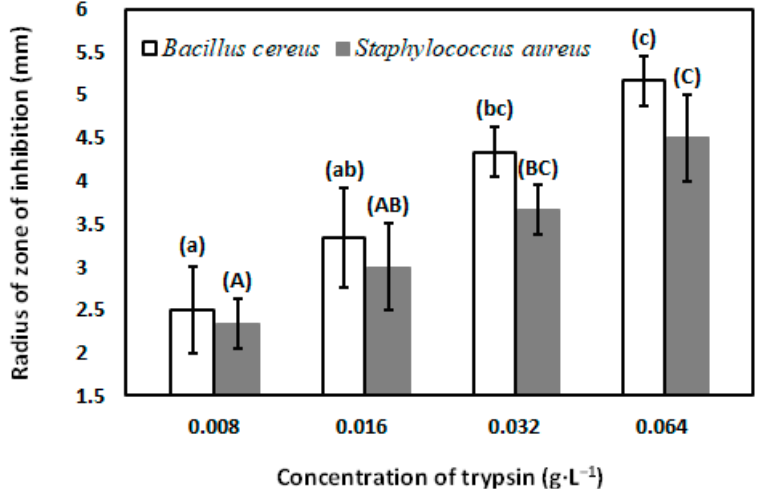
Figure 9. Antibacterial activity of milk with concentrated proteins after enzyme treatment. Results are represented by mean value with standard deviation (± values). Superscript dissimilar alphabet represents the significant difference between results, evaluated by the Tukey’s post hoc method.